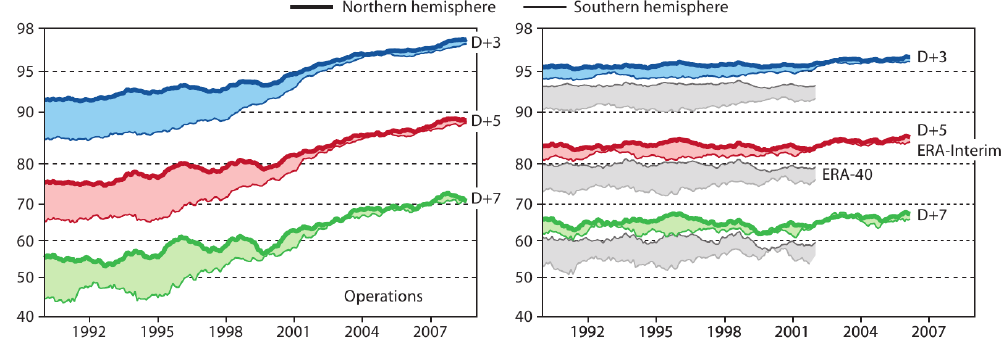
Figure 4. Performance of the forecast: anomaly correlation at 500hPa height forecast (courtesy of ECMWF).